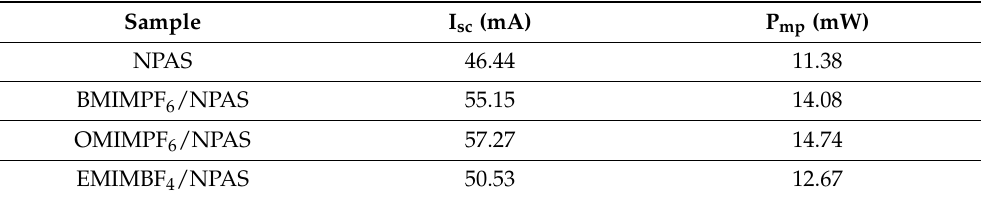
Table 6. Average values of short circuit current (I sc ) and power at the maximum power point (P mp ) determined for the three IL/NPAS